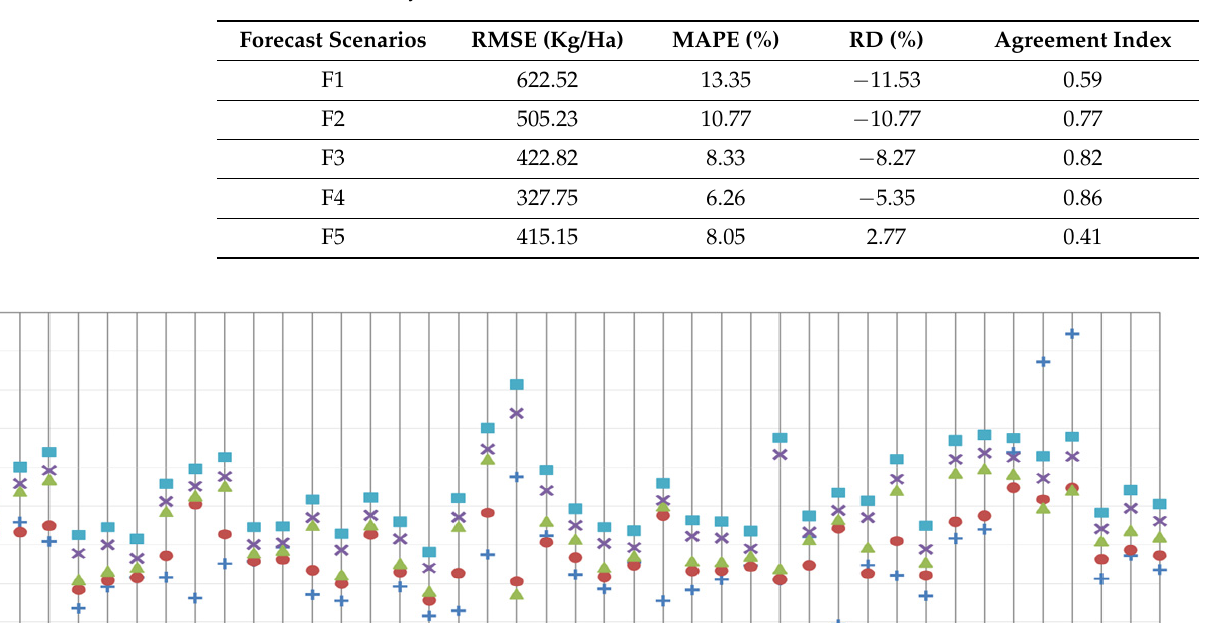
Table 6. Simulated yield error statistics across districts.